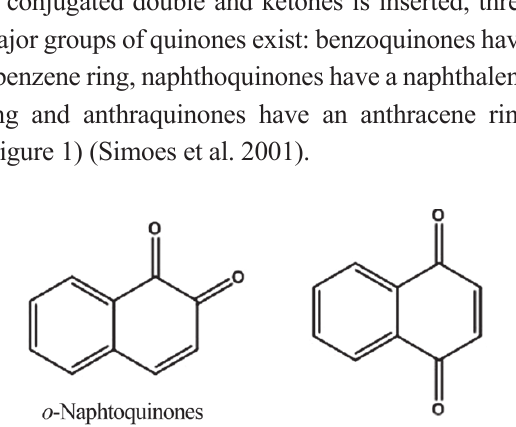
B IFLORIN C HARACTERIZATION The first studies with phytochemicals from